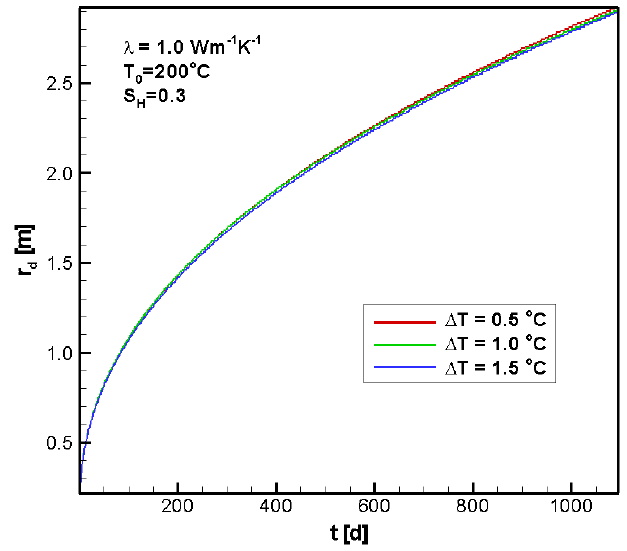
Figure 8. Evolution of hydrate dissociation radius and its sensitivity to the temperature